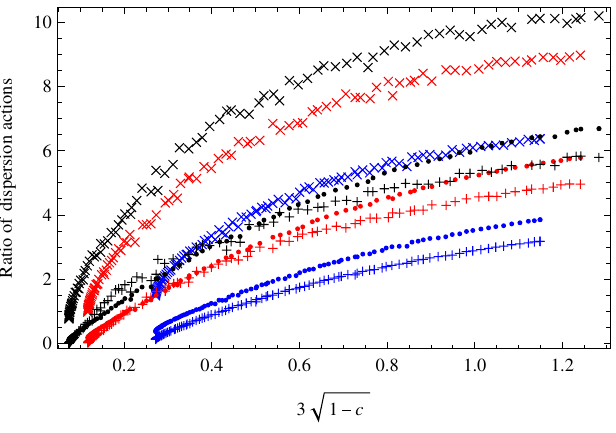
FIG. 12. Ratio of dispersion action of AME ( (cid:2) ), TME ( þ ), and EME ( (cid:7) ) dipoles to the TME dipole at different peak-field factor of 2 (blue), 4 (red), and 6 (black). The corresponding ratios for uniform dipoles are 3, 1, and 1.4,